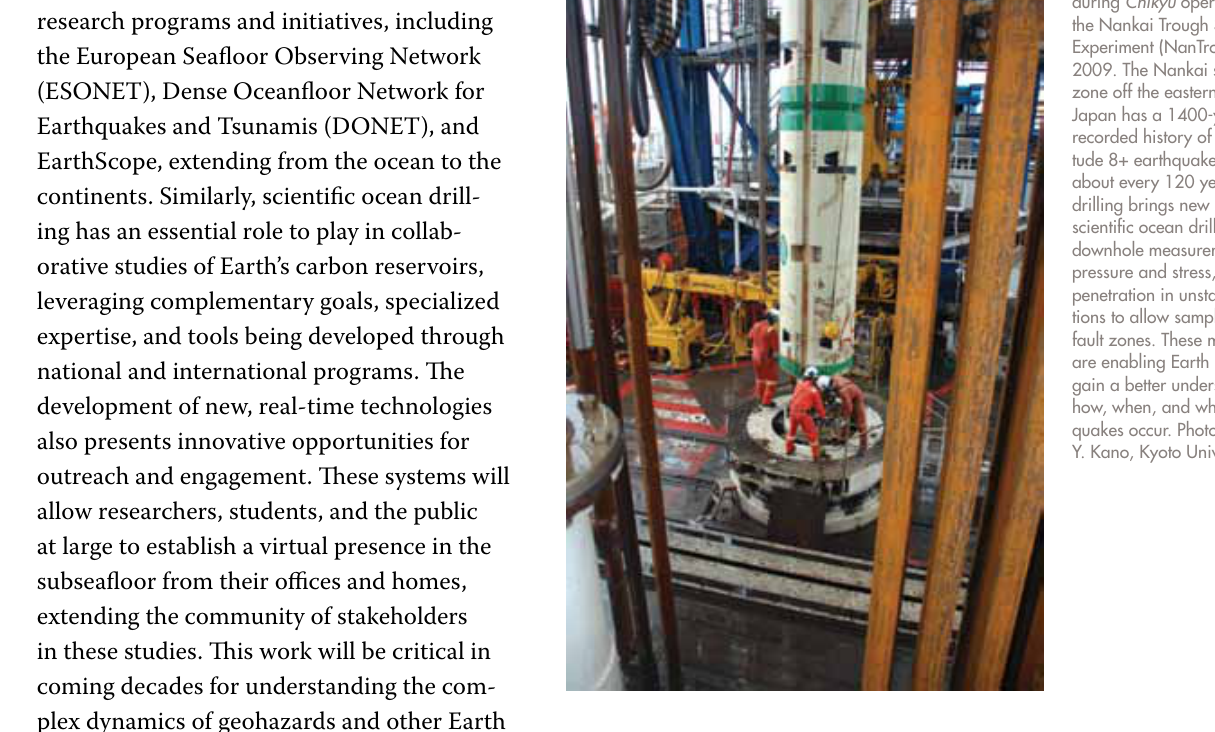
figure 5.1. rigging the riser during Chikyu operations for the nankai Trough seismogenic experiment (nanTroseiZe) in 2009. The nankai subduction zone off the eastern coast of Japan has a 1400-year-long recorded history of magni- tude 8+ earthquakes recurring about every 120 years. riser drilling brings new capabilities to scientific ocean drilling, including downhole measurements of pore pressure and stress, and deep penetration in unstable forma- tions to allow sampling of active fault zones. These measurements are enabling earth scientists to gain a better understanding of how, when, and why great earth- quakes occur. photo courtesy of y. Kano, Kyoto